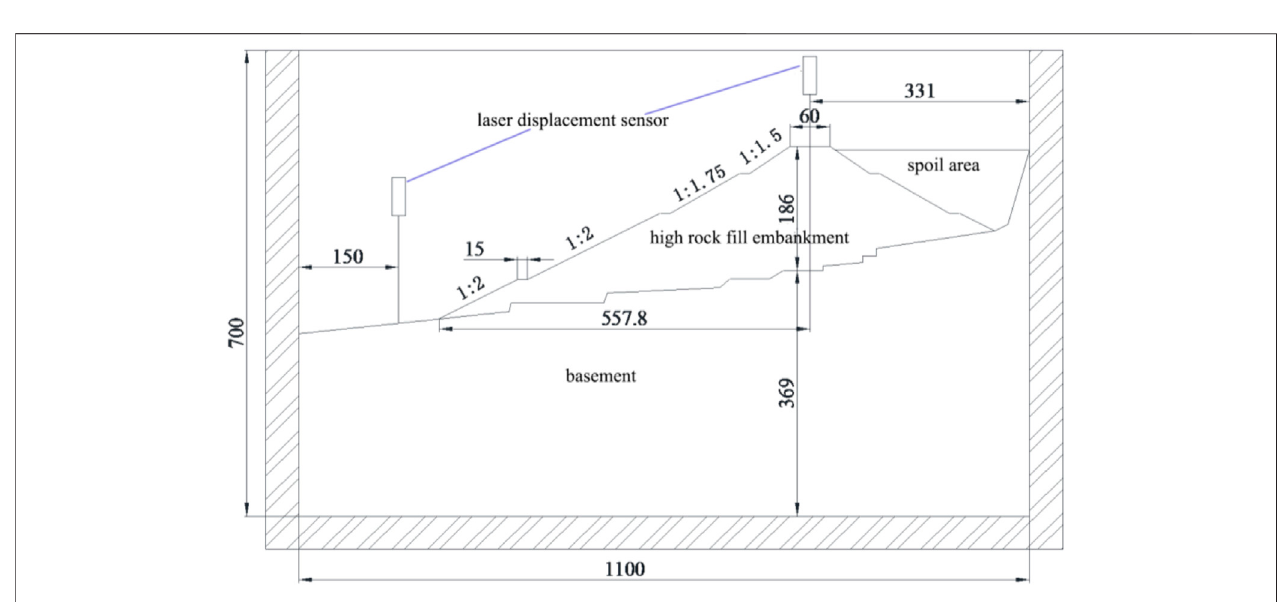
FIGURE 2 | Experimental model